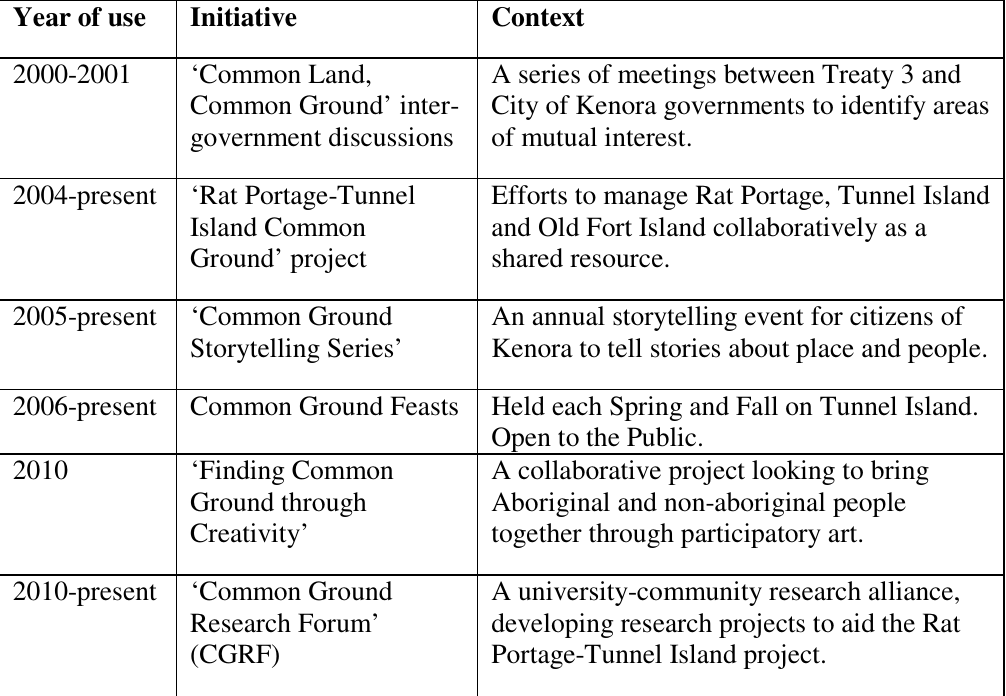
Table 1.1 – Usage of the term common ground in local initiatives in